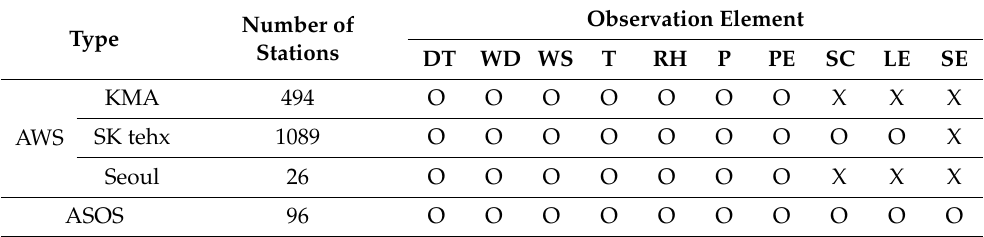
Table 1. Features of weather observation